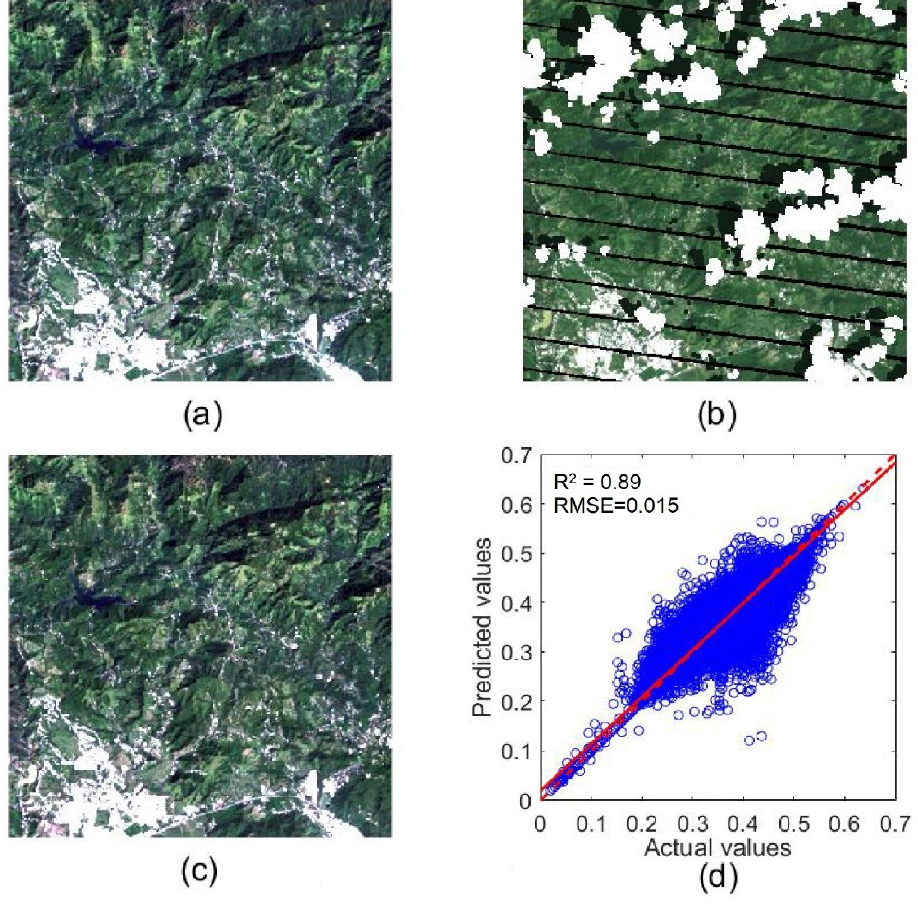
Figure 9. A true-color clear sub-image on 18 October 2008 ( a ); the corresponding simulated cloudy image ( b ); gap, cloud, and shadow removed by NSPI ( c ); and the scatter plot between the actual values and predicated values of NIR band ( d ).